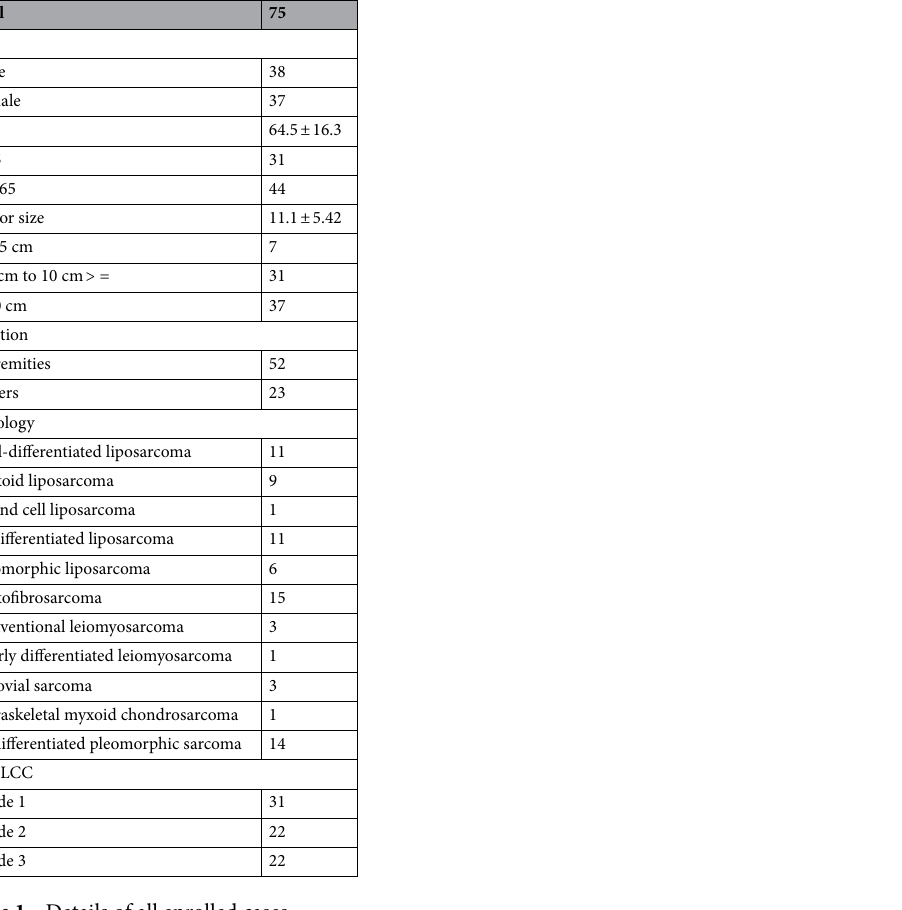
Table 1. Details of all enrolled